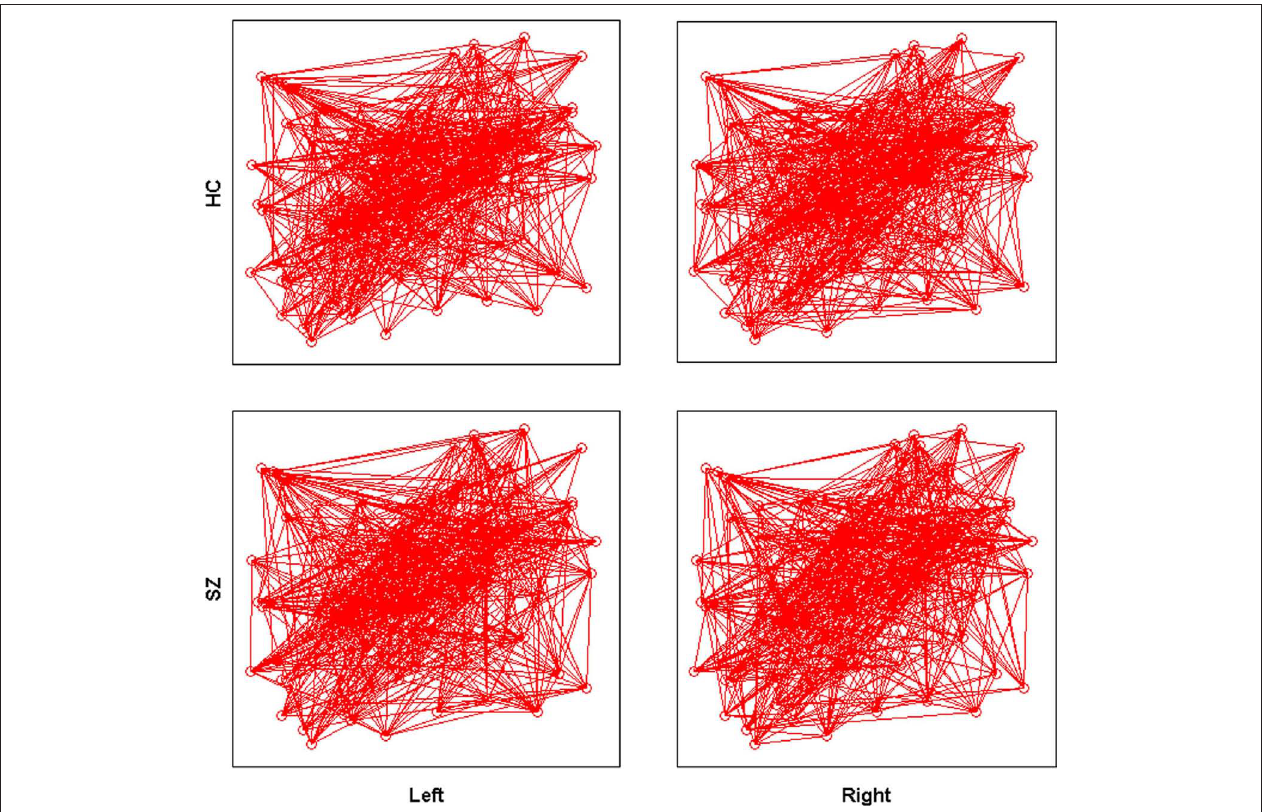
FIguRe A2 | graph of networks built from mean absolute z -score matrices for HCs and SZ at degree K = 13.0. Red circles are nodes (voxels). Red lines are edges. Nodes are randomly organized but HCs and SZ have the same organization. Left: the left task-related network; Right: the right task-related network.